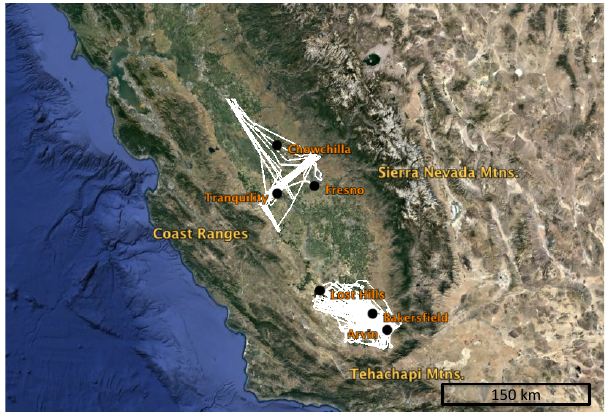
Figure 2. Flight paths of all data observed in the ABL for the two projects of this study: DISCOVER-AQ near Fresno from January and February 2013 (region 1), and the ArvinO3 project sampling from June to September over two summers and carefully mapping the inflow region upwind of Bakersfield and Arvin (region